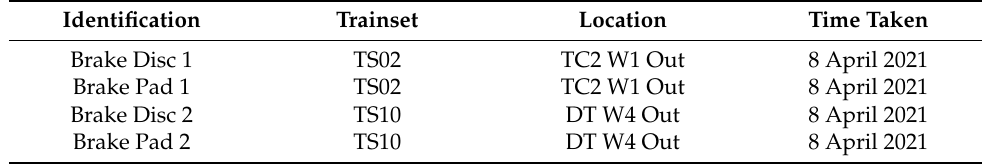
Table 2. Sample details for examination.